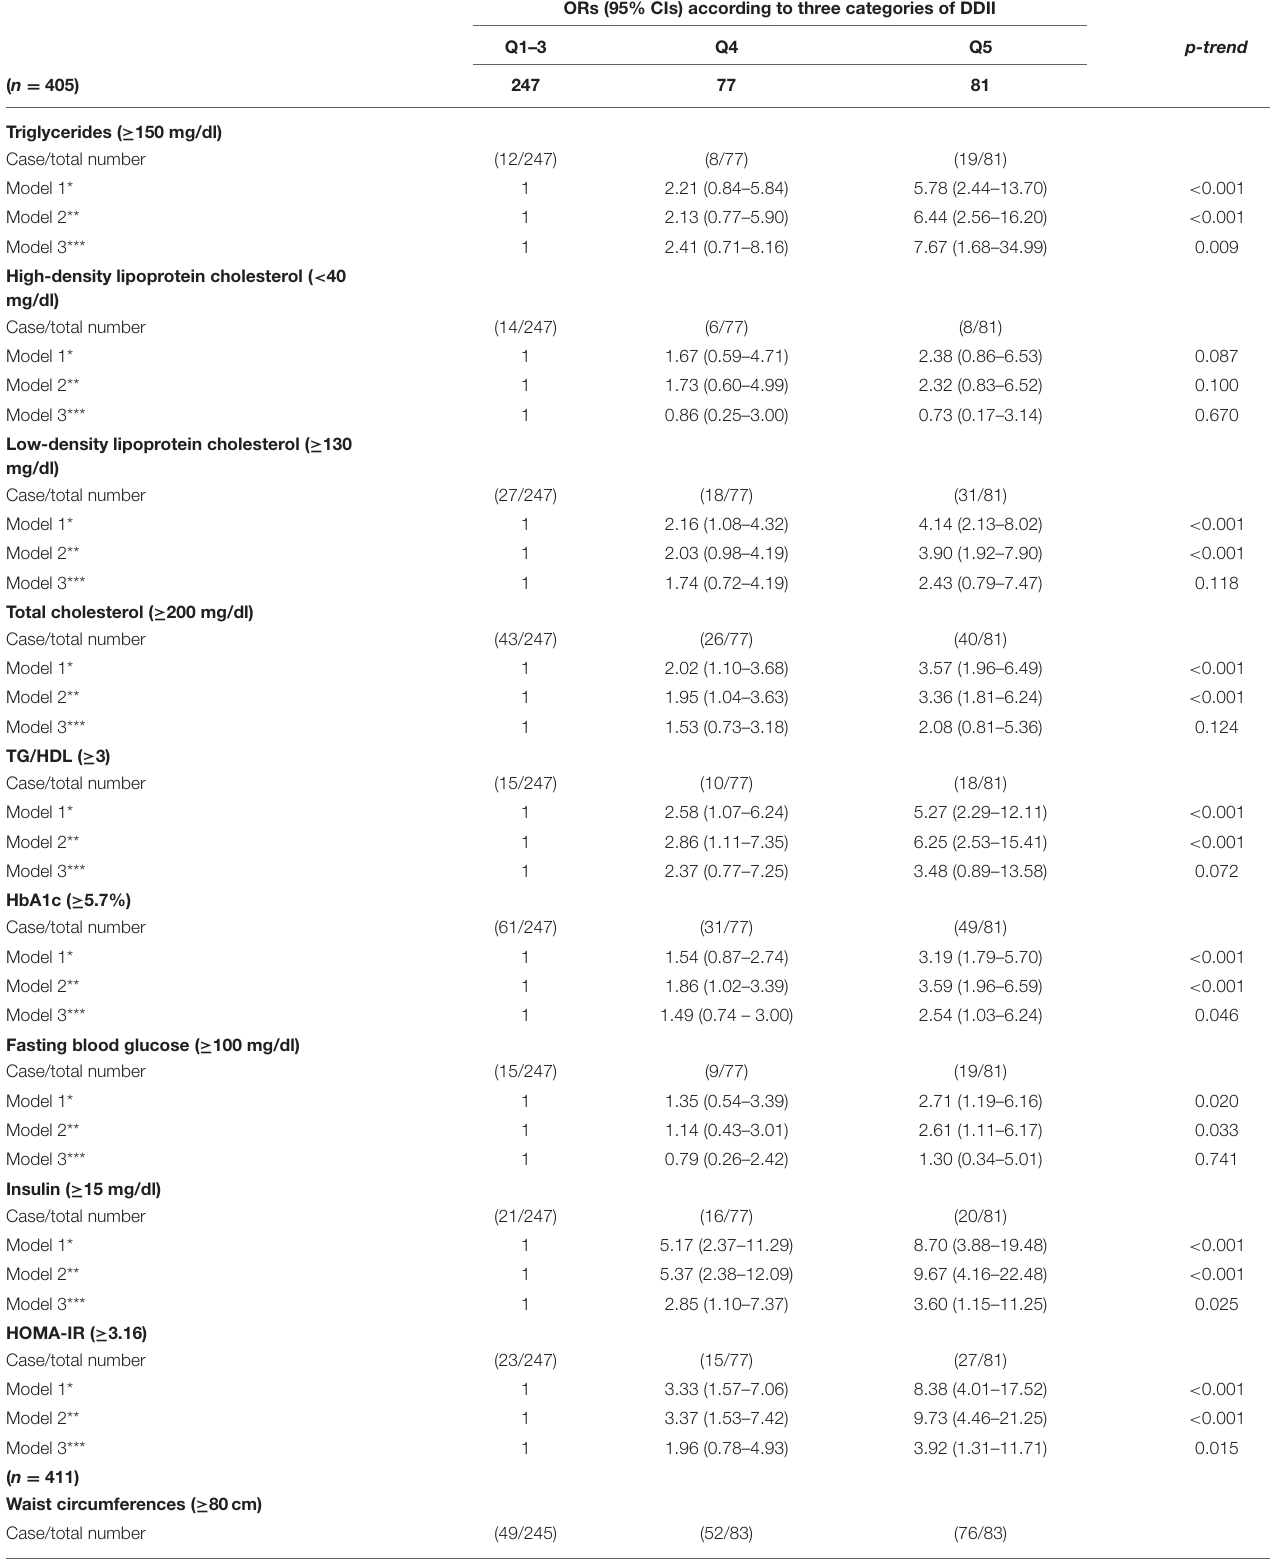
TABLE 4 | Odds ratios (ORs) and 95% confidence intervals (CIs) of triglycerides, HDL-C, LDL-C, total cholesterols, TG/HDL, HbA1c, fasting blood glucose, insulin, HOMA-IR, and waist circumferences according to DDII in the FiLWHEL study. ORs (95% CIs) according to three categories of DDII Q1–3 Q4 Q5